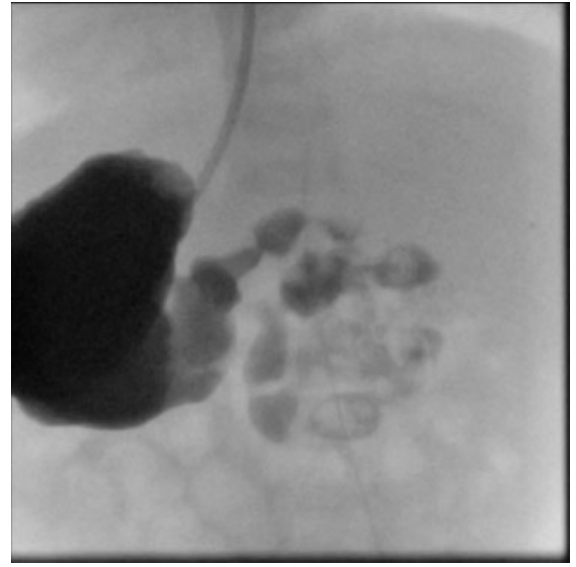
Fig. 1 Upper gastrointestinal contrast study showing a right-sided stomach and an abnormal position of the duodenojejunal fl exure, suggestive of malrotation.